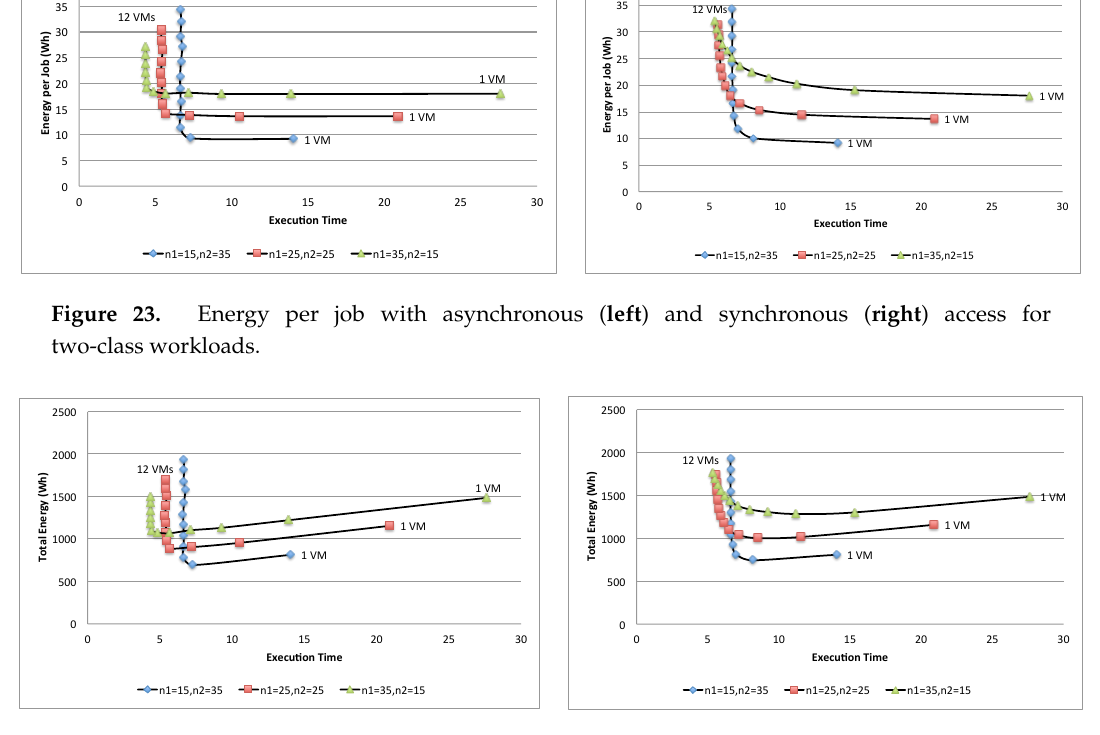
Figure 24. Total energy with asynchronous ( left ) and synchronous ( right ) access for two-class workloads.